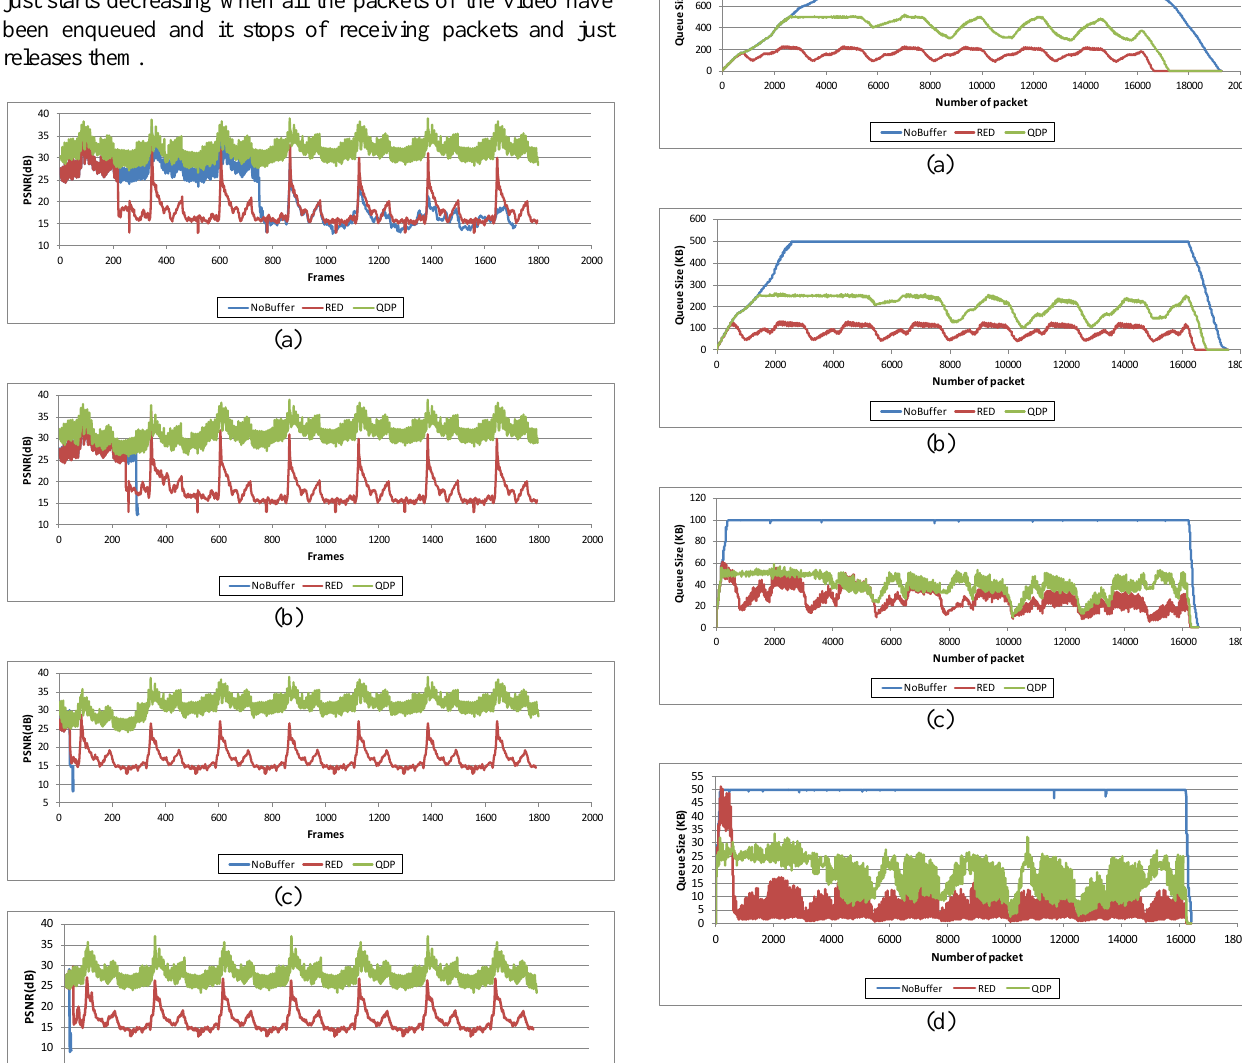
Figure 5. Buffer occupancy to different buffer sizes: (a) 1 MB, (b) 500 KB, (c) 100 KB and (d)